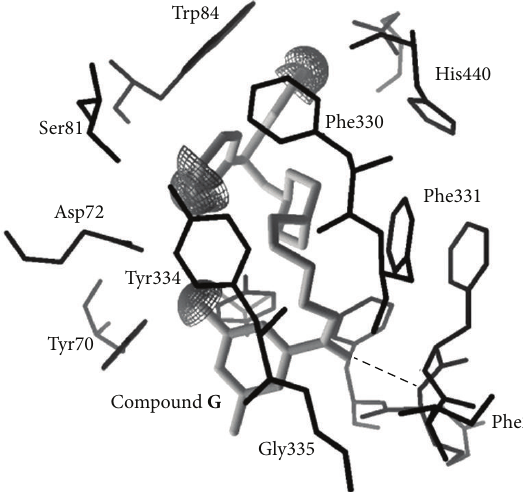
Figure 2: Docking result of the conformation corresponding to compound 2 inside the AChE active site. Table 4: Proposed structures of new potential inhibitors.